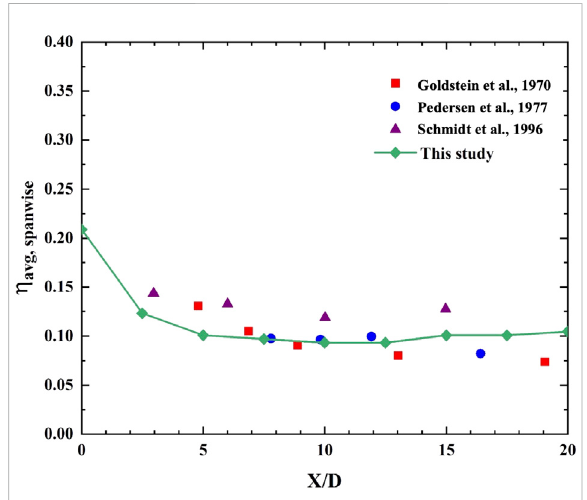
FIGURE 4 Experimental validation by comparison between published data and this